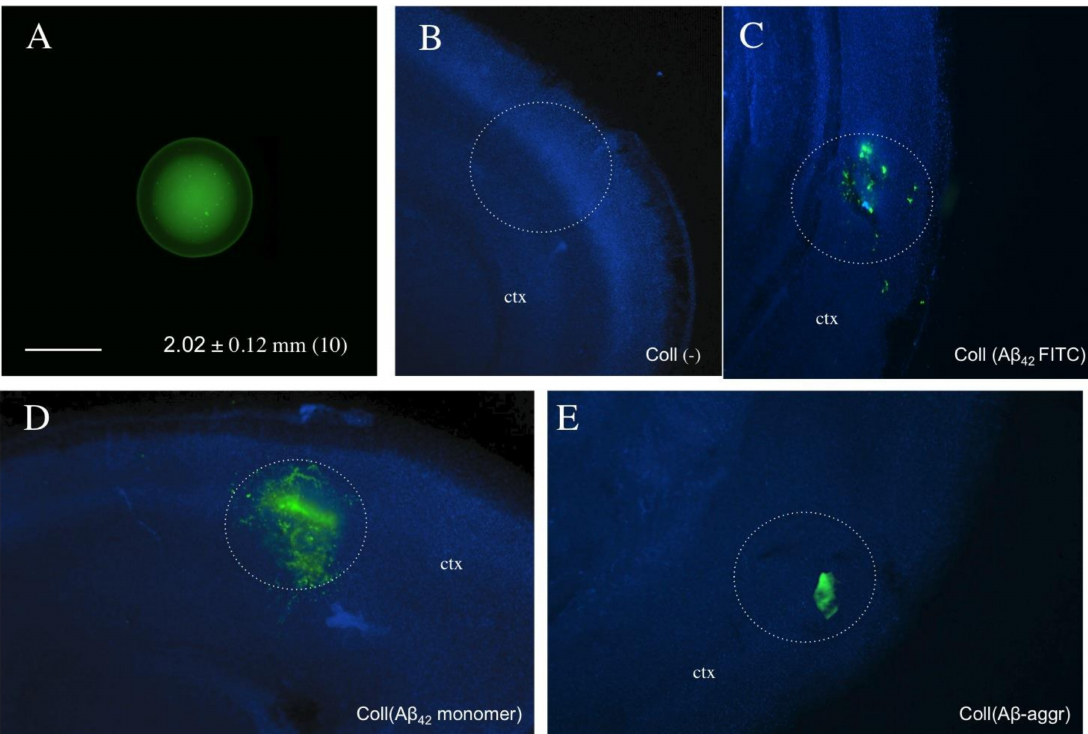
Figure 2. Characterization of the collagen hydrogel and placement on a brain slice (white circles). The collagen hydrogel had a size of approximately 2 mm ( n = 10) and became visible with fluorescently stained green Alexa-488 ( A ). Collagen hydrogels were loaded without ( B ) or with Fluoresceinisothiocyanat (FITC)-labeled beta-amyloid-42 ( C ), or with human beta-amyloid-42 ( D ) or aggregated beta-amyloid-42 ( E ) and placed on brain slices, incubated for two days and then fixed and counterstained with nuclear DAPI (blue). The hA β 42 may exist in monomeric or oligomeric forms or may partly aggregate in the hydrogel (see also Western blots in Figure 4). Only background staining was visible when the empty hydrogel (Coll(–)) was loaded ( B ) and green fluorescence was seen with the FITC-labeled beta-amyloid-42 ( C ). Collagen hydrogel loaded with unconjugated beta-amyloid was made visible by immunostaining using antibodies with anti-mouse A488 (green, D , E ). Scale bar in A = 1.5 mm ( A – E ). ctx,